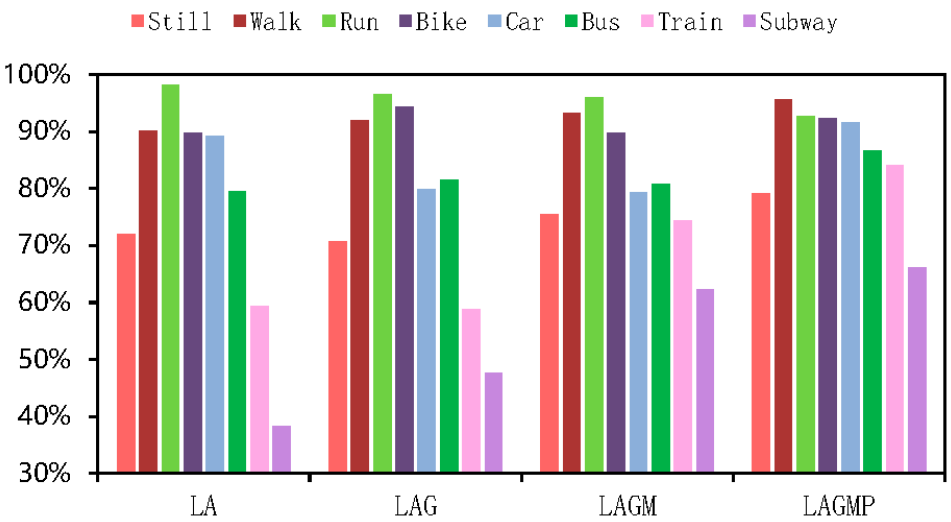
Figure 16. Precisions of DFTrans obtained using different sensor variables on the SHL dataset.